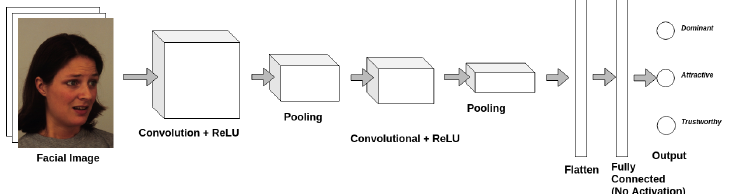
Figure 5. General CNN architecture used to learn the three social traits of interest. The architecture is implemented in TensorFlow